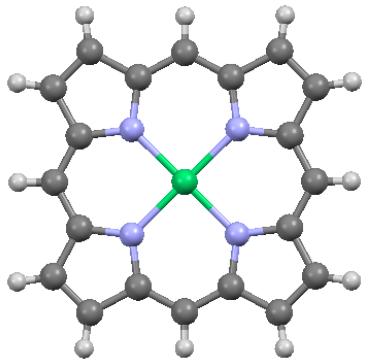
Figure 5. Ni-porphine, from data of [7,16]. Green = Ni.